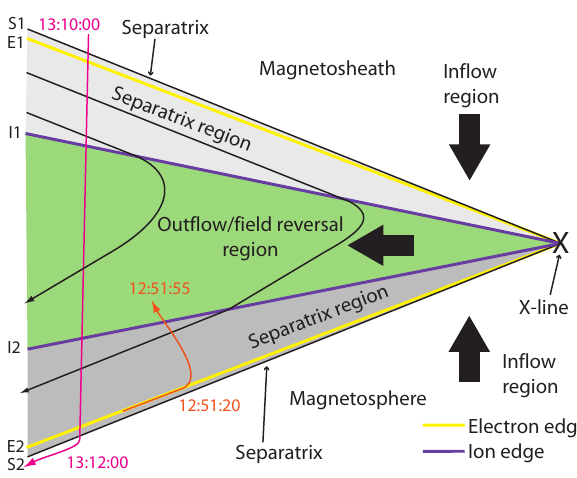
Fig. 1. Simplified sketch of a reconnection layer formed by an X-line at the magnetopause. The separatrices are the magnetic field lines connected to the reconnection X-line. Just inside the separatrix are the electron edges in yellow. The purple lines illustrate the ion edges that are closer together than the electron edges due to the time-of-flight effect. Between the separatrices and ion edges are the separatrix regions in grey. Between the ion edges is the outflow region. Spacecraft orbits for the two events that are discussed in detail are shown by orange (12:51UT) and pink (13:11UT)